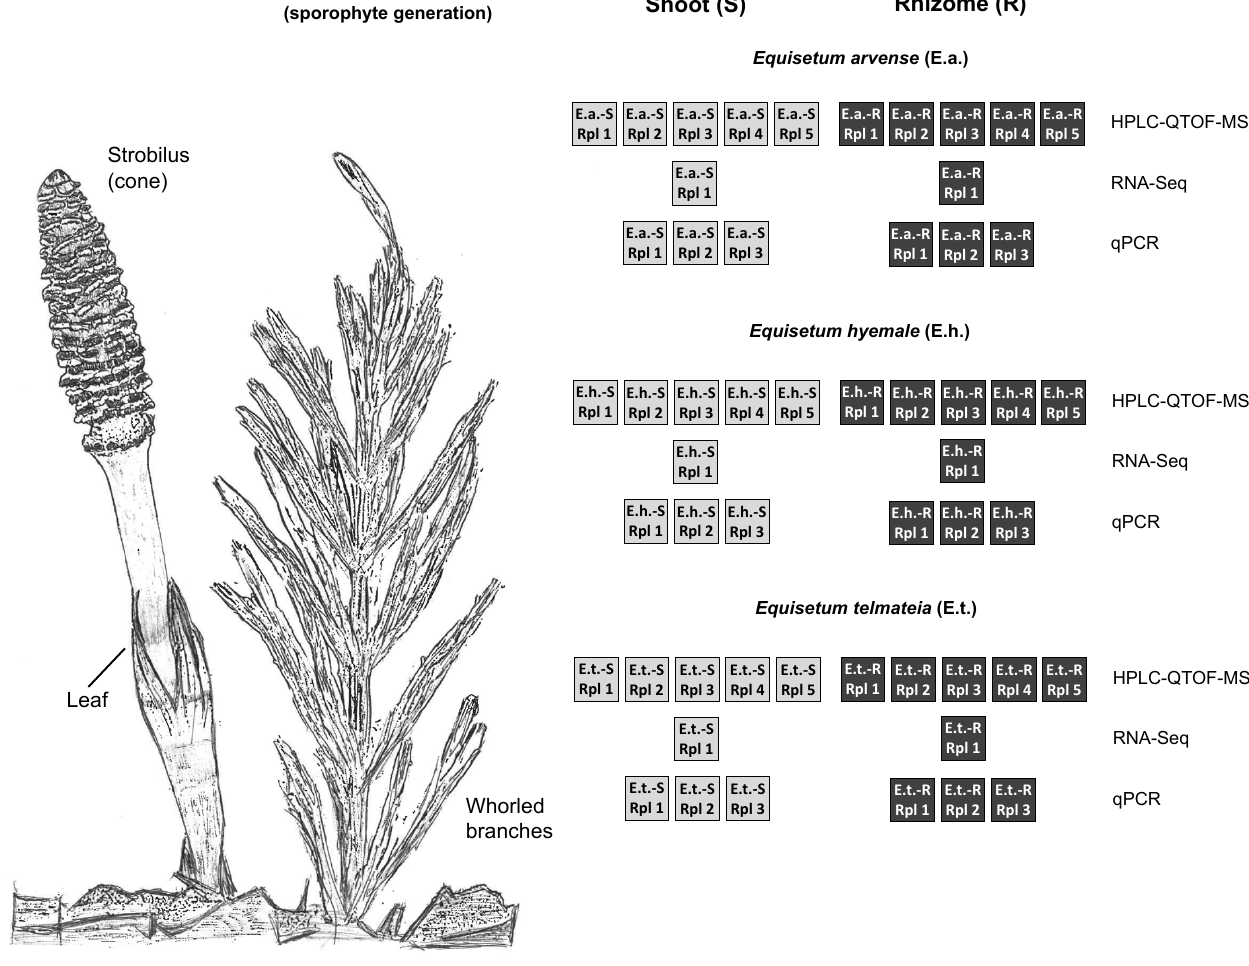
Figure 1. Multi-omics analysis of Equisetum samples. ( A ) Sketch of a fertile and sterile shoot. ( B ) Experimental design. Abbreviations: E.a., Equisetum arvense ; E.h., Equisetum hyemale ; E.t., Equisetum telmateia ; HPLC–QTOF-MS, high-performance liquid–quadrupole time-of-flight mass spectrometry; RT-qPCR, quantitative real-time polymerase chain reaction; R, rhizome; RNA-Seq, next-generation ribonucleic acid sequencing; Rpl, replicate; S, shoot.